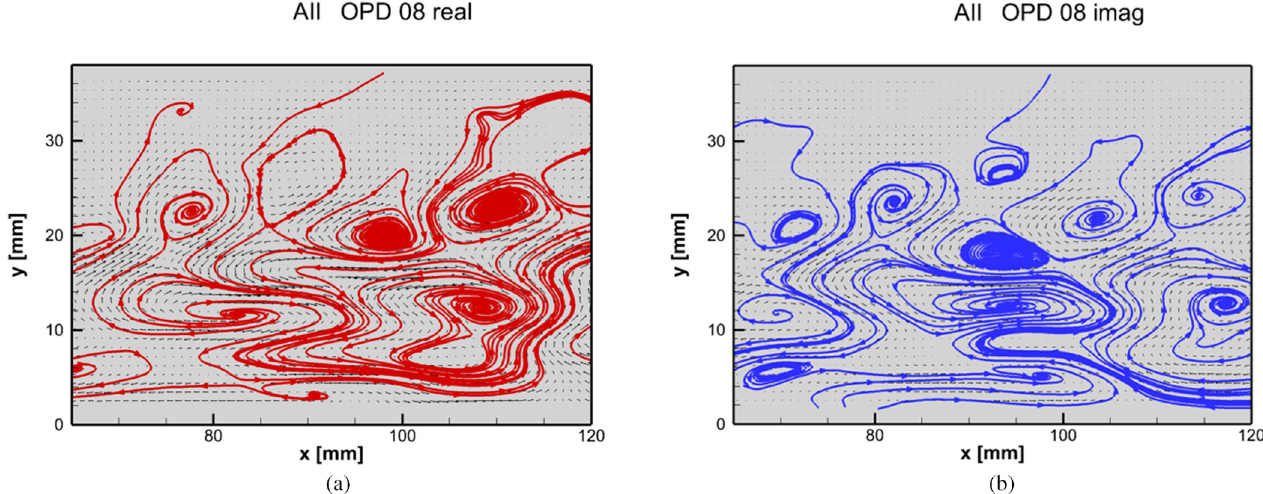
Fig. 14. Topology of the OPD mode no. 8 in the branch A, zone II, real (a) and imaginary (b)